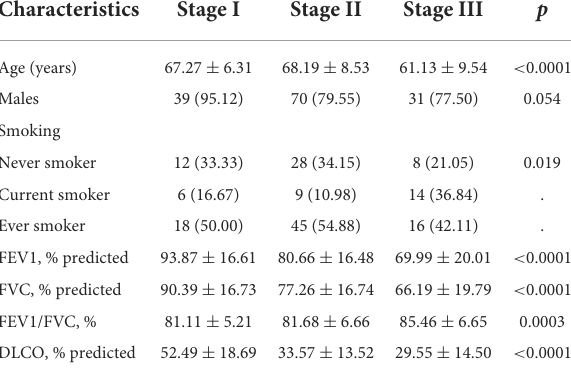
TABLE 6 Characteristics of patients with IPF stratified by CPB stage in the derivation cohort. Characteristics